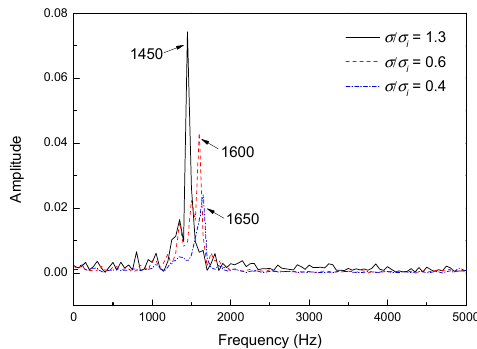
Figure 5. Spectra of the time evolution of the lift coefficient at free cavitation conditions ( σ / σ i = 1.3) and at two cavitation conditions ( σ / σ i = 0.6 and 0.4).